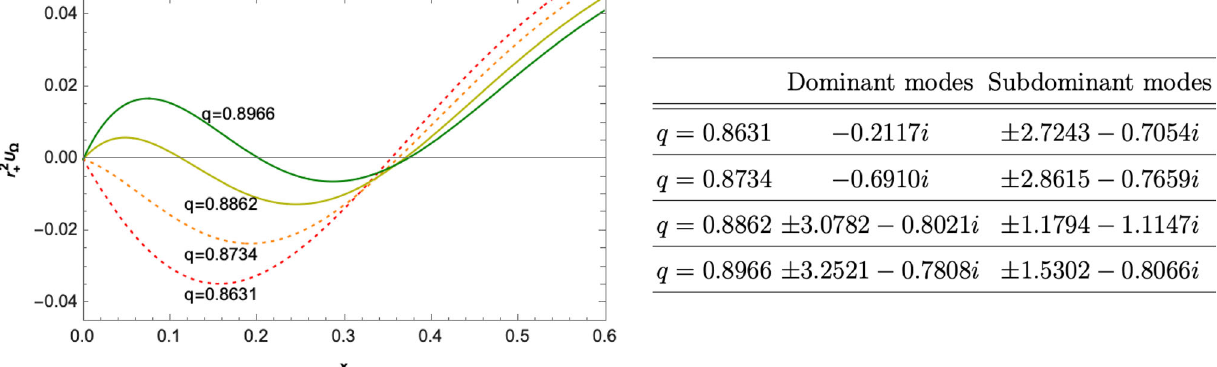
Fig. 3 Effective potentials r 2 + U (cid:18) of fundamental scalarized black holes with α = 5 as functions of x for different values of q (left) and the corresponding dominant and subdominant quasinormal frequencies